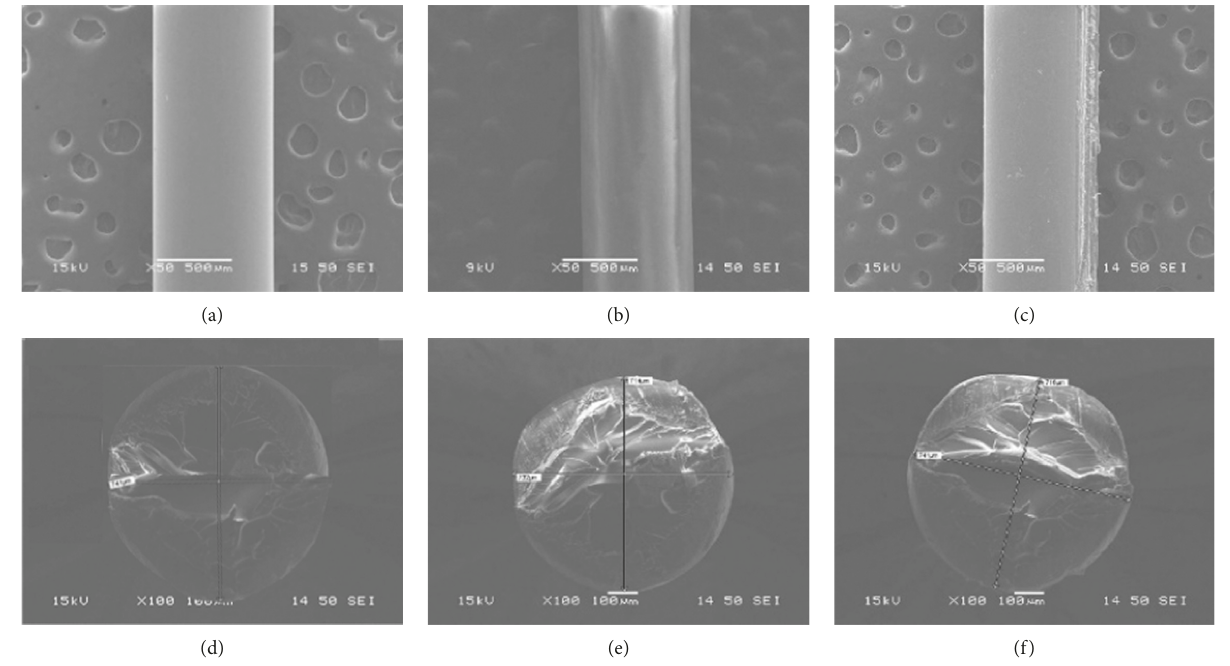
Figure 9: Result of half removal of cladding using chemical and mechanical methods. (a) Untreated fiber (PGR-FB750). (b) Half removal using acetone. (c) Half removal using sandpaper. (d) Untreated fiber (cross section). (e) Half removal using acetone (cross section). (f) Half removal using sandpaper (cross section).